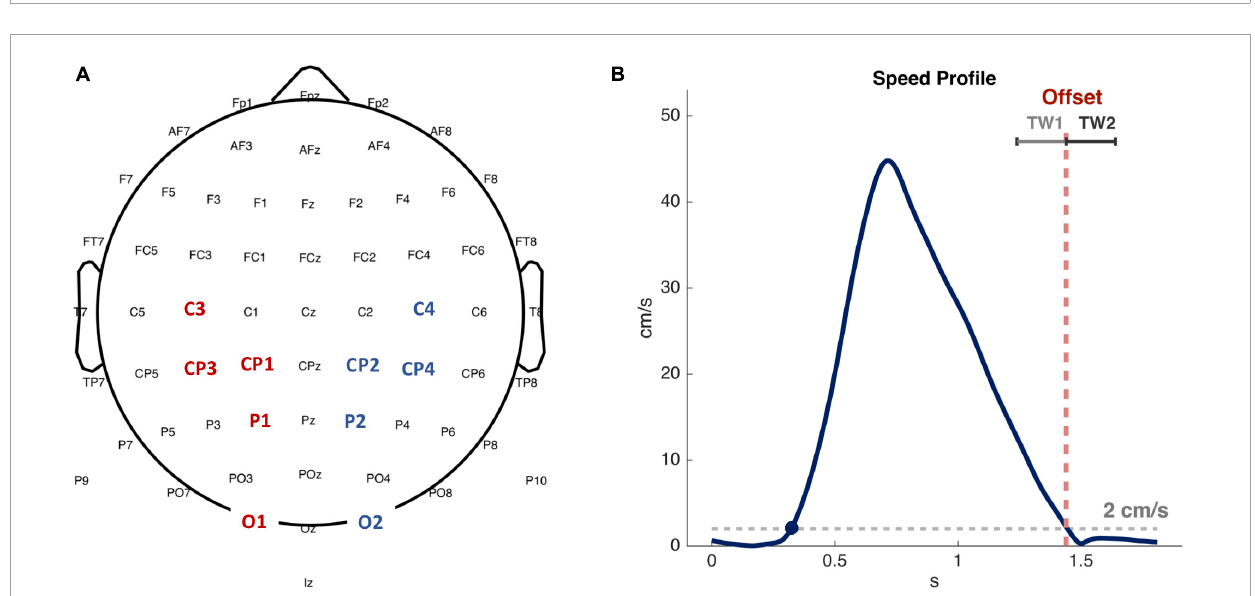
FIGURE2 Electroencephalographic (EEG) analyzed ROIs and time intervals. (A) Channels considered in the analysis. Red and blue labels indicate channels in the left and right hemispheres, respectively. (B) An illustrative example of a bell-shaped speed profile corresponding to an active matching movement. The average duration of the active matching movement from the onset (blue dot) to the offset was 1.2 s for our sample of subjects. Red dotted line highlights movement offset, corresponding to the time in which the speed decreases below the threshold of 2 cm/s. TW1 and TW2 are the time windows of 200 ms in which EEG signals have been averaged and analyzed.